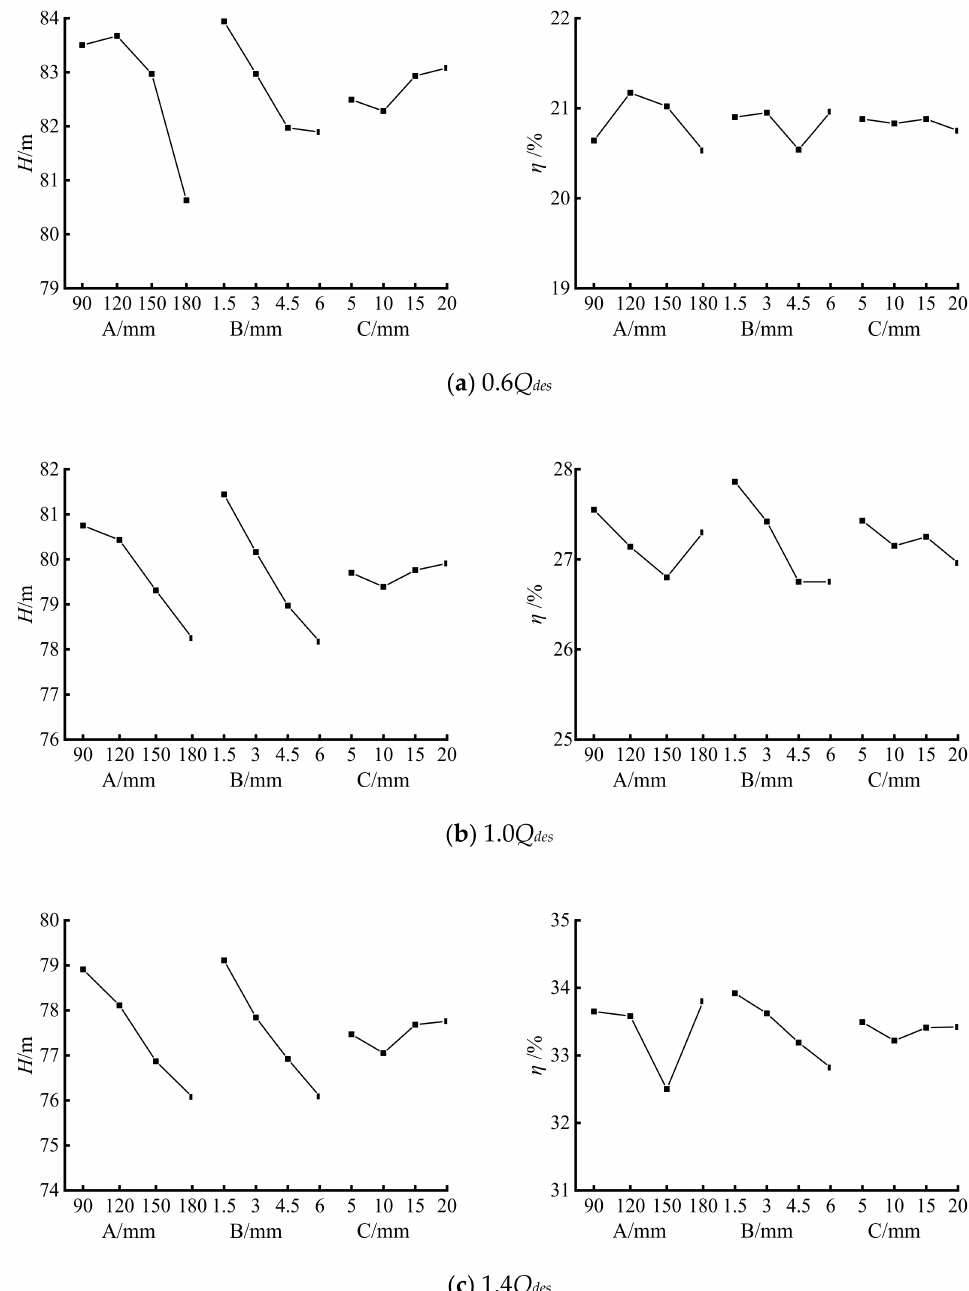
Figure 7. Trend chart of pump